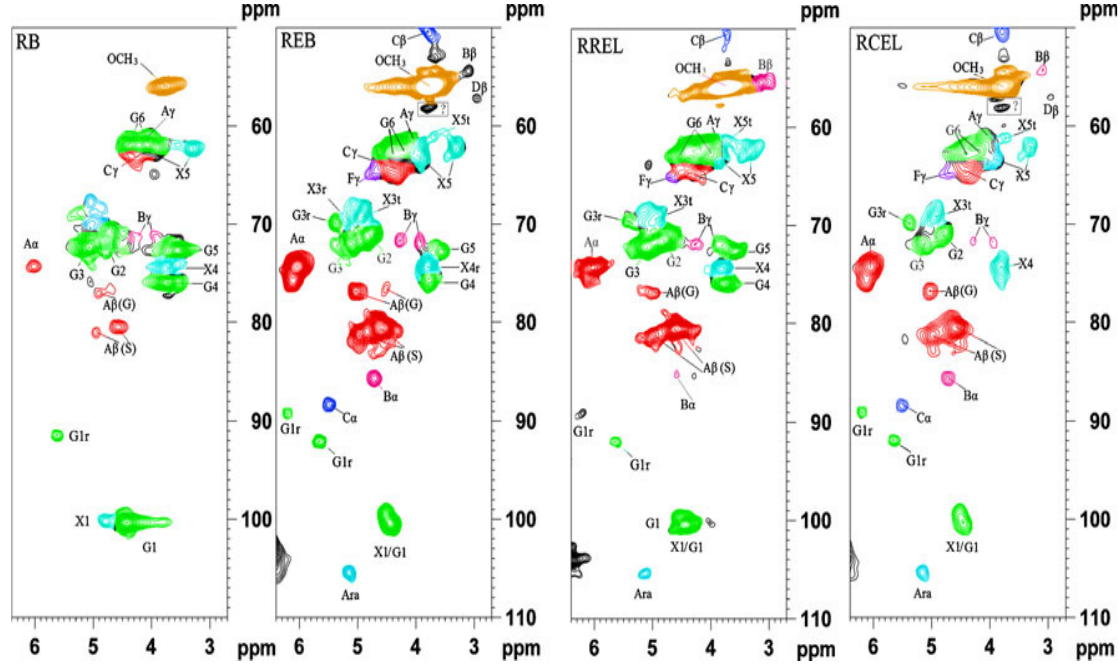
Figure 9. The side chain region of HSQC spectra of the acetylated bamboo samples (RB, regenerated bamboo from DMSO/NMI solvent system; REB, residue after enzymatic hydrolysis of RB; RCEL, dioxane lignin extracted from REB; RREL, residue after RCEL extraction from REB. The lignin structures identified are also shown: ( A ) β -O-4' substructure; ( B ) resinol substructure; ( C ) phenylcoumaran substructure; ( F ) p -hydroxycinnamyl alcohol end groups; ( G ) β -glucan; ( X ) xylan ( A ) arabinose (Reprinted from [65]. Copyright 2012